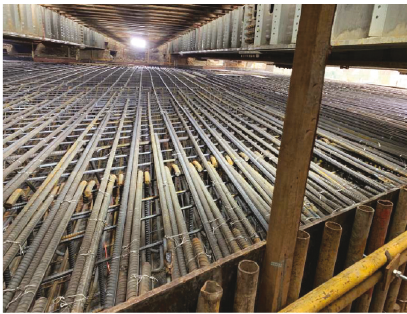
Figure 2: Positional relationship between horizontal steel bars in tunnel cross section and existing railway line.